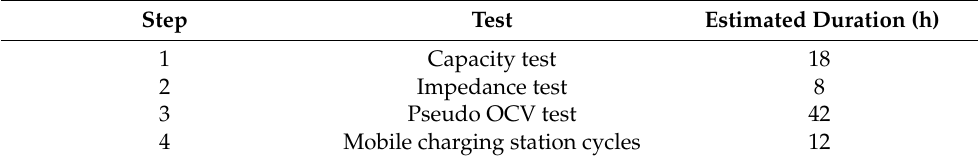
Table 2. Reference characterization